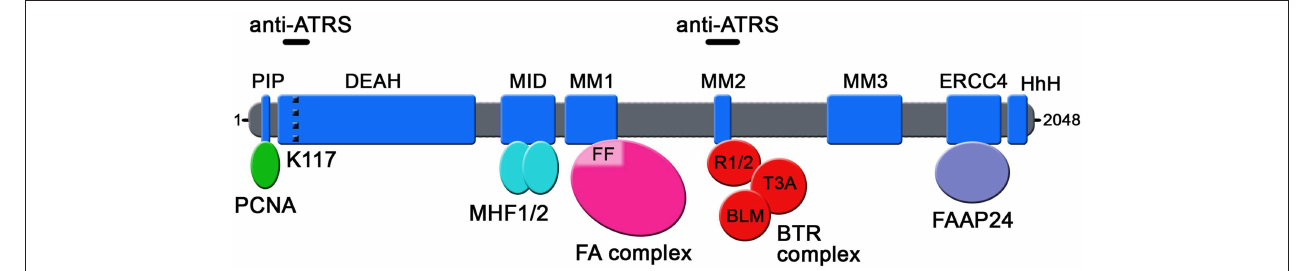
FIGURE 1 | Schematic representation of the domains so far identified in human FANCM protein. The position of lysine 117 (K117) within the ATPase pocket is indicated by a dotted black line. FF: FANCF; R1/2: RMI1 and RMI2; T3A: TOP3A; anti-ATRS: regions identified as necessary for FANCM function in suppressing ALT-associated telomeric replication